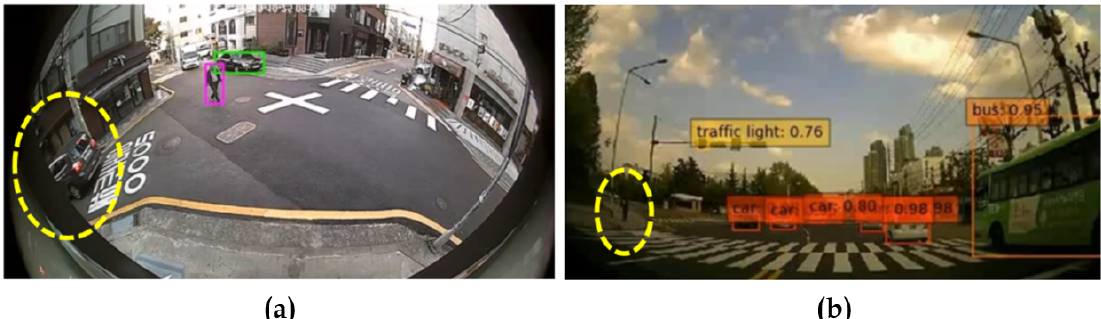
Figure 8. Performance of pretrained state-of-the-art (SOTA) models on different larger FOV raw samples: ( a ) Pretrained YOLOv3 on 190 ◦ fish-eye sample (car undetected along the edge); ( b ) Pretrained SSD on 120 ◦ wide-angle sample (person undetected along the